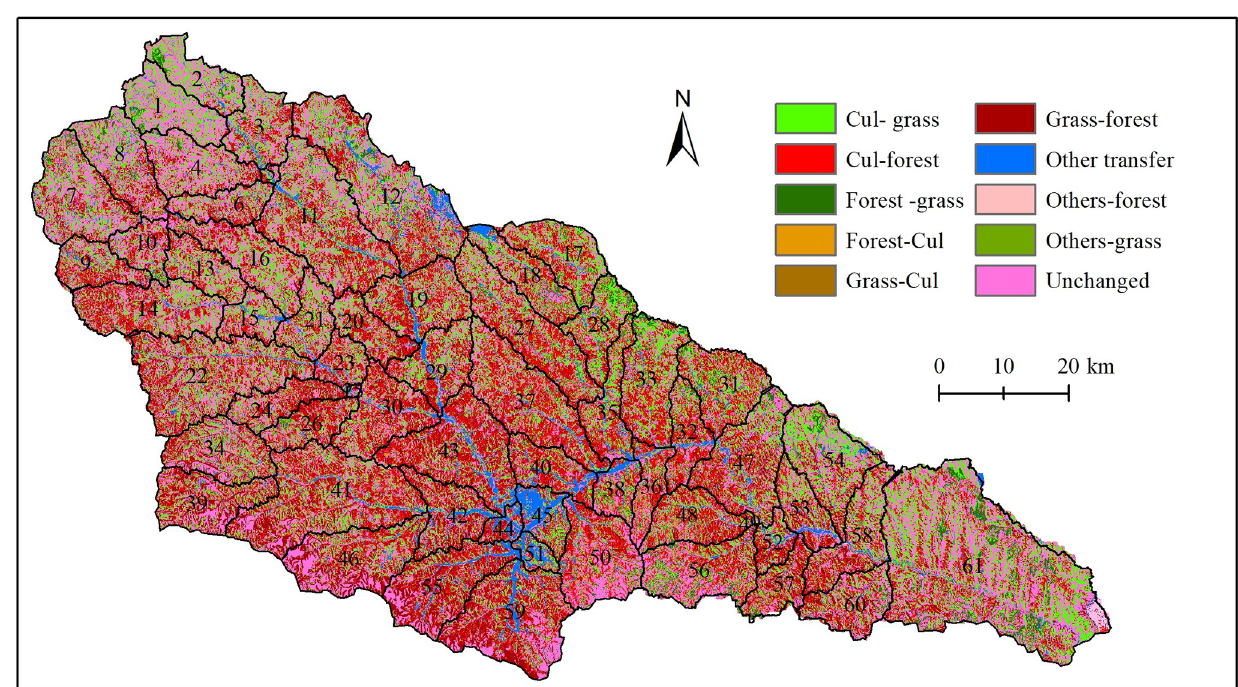
Fig 8. Land use conversions between 1980 and 2017. The map was prepared in ARCGIS using markov model.